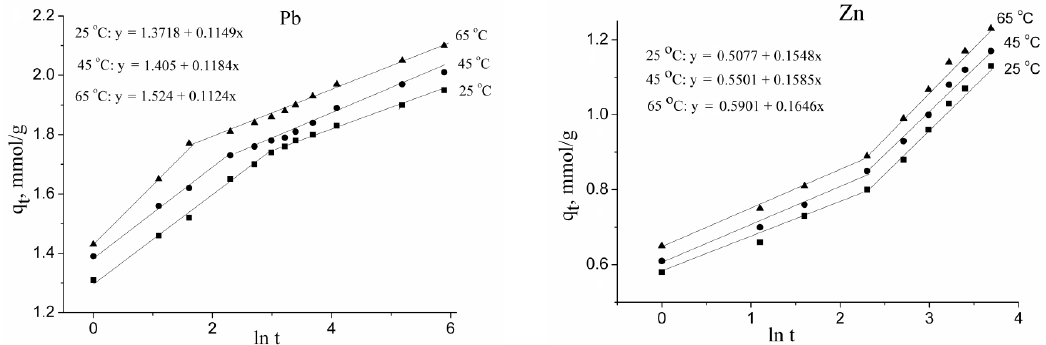
Figure A2. Pseudo-second-order kinetics plots for Pb 2+ and Zn 2+ ion adsorption on titanium phosphate (the initial concentration of metal ions was 10 mmol·L −1 ). Int. J. Mol. Sci. 2020 , 21 , x